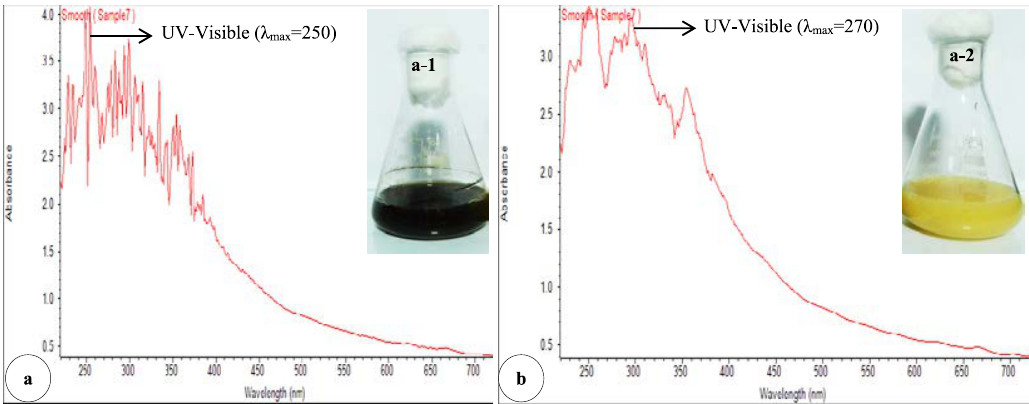
Fig. 1. UV-Vis spectroscopy analysis for investigate the degradability of pollutants at 250- 700 nm before and after biostimulation process (a.a-1).Effluent before biostimulation process (b. b-2). Effluent after biostimulation